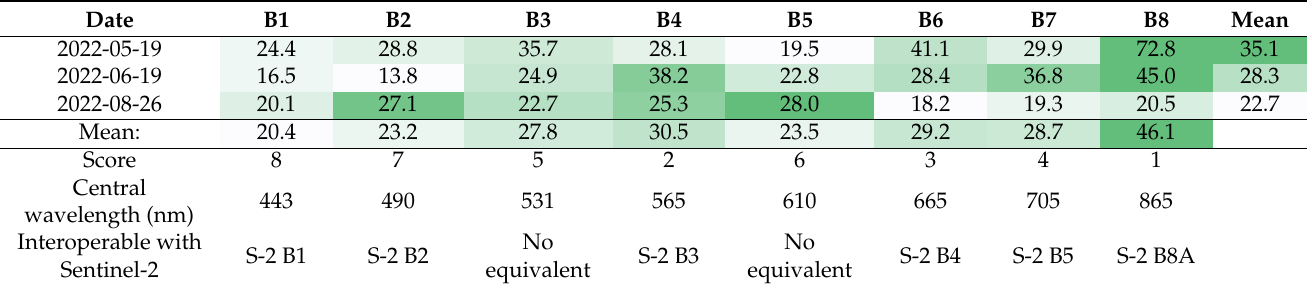
Table 3. Relationship of variable importance (mean decrease in accuracy) between PlanetScope bands and acquisition dates (values for topographic features; DEM: 94.4; slope: 30.7; aspect: 9.3). The importance of the bands was confirmed by the intensity of the green color.